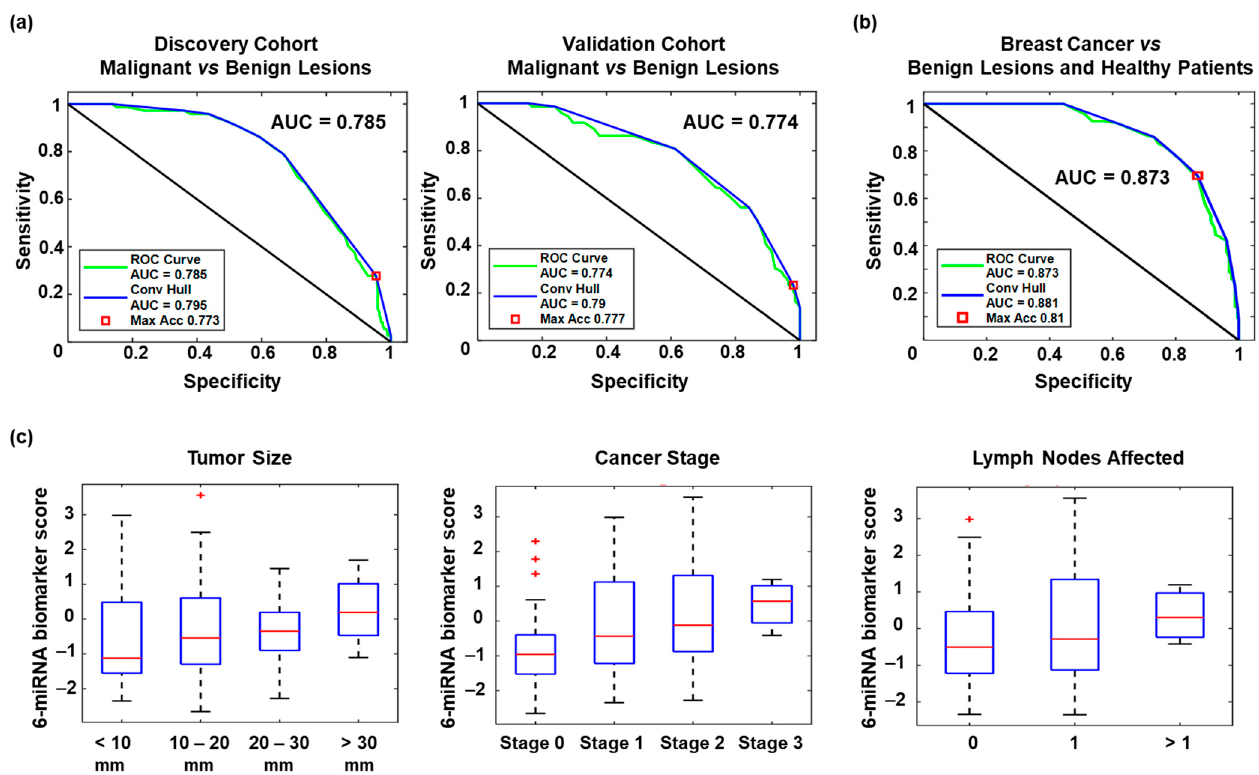
Figure 3. Biomarker panel validation. ( a ) ROC curves for the optimal 6-miRNA biomarker panels used in distinguishing patients with breast cancer from those with benign breast nodule in the Discovery (left panel) and Validation cohort (right panel). ( b ) ROC curves for the optimal 6-miRNA biomarker panels used in distinguishing patients with breast cancer from those with benign breast lesions and normal mammograms. ( c ) Box and whiskers plots of 6-miRNA biomarker scores in differentiating breast cancers by tumor size, stage, and number of lymph nodes affected.